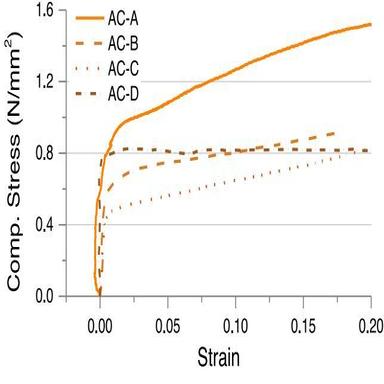
Stress–strain plots (AC).